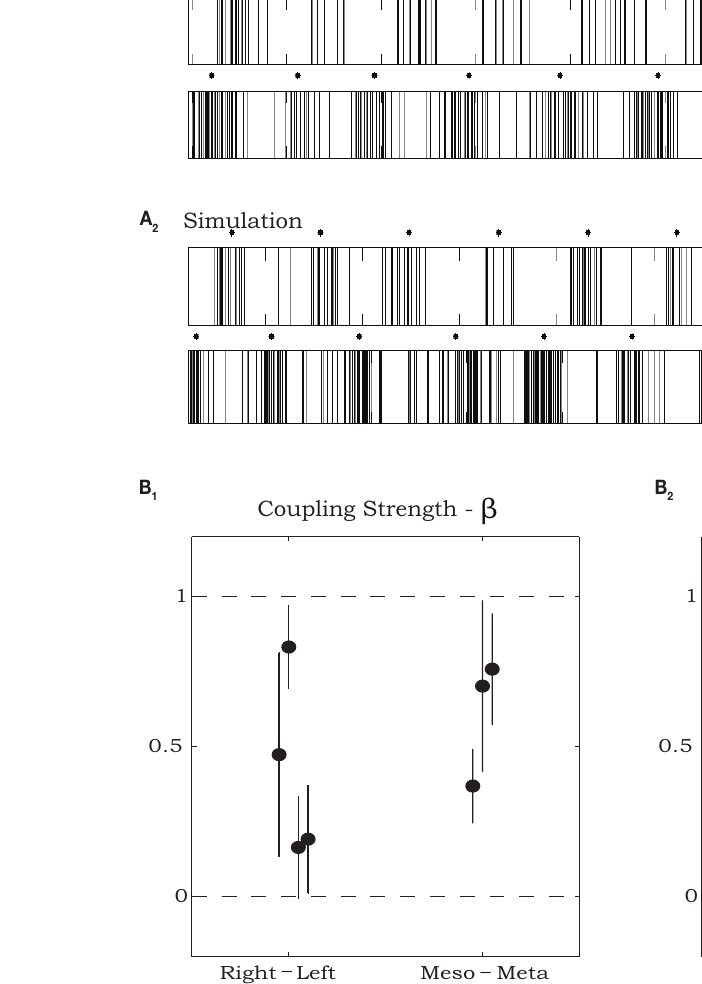
) and symmetry index γ 1